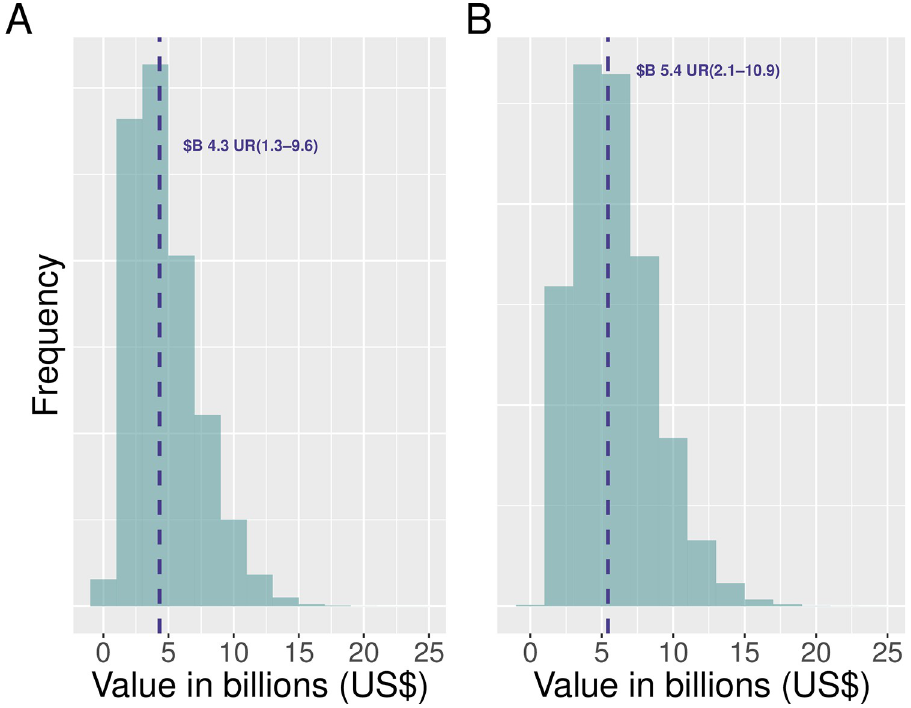
Fig 1. Uncertainty distribution of USA IWT values. A and B: USA IWT economic values using normal and uniform uncertainty distributions respectively.